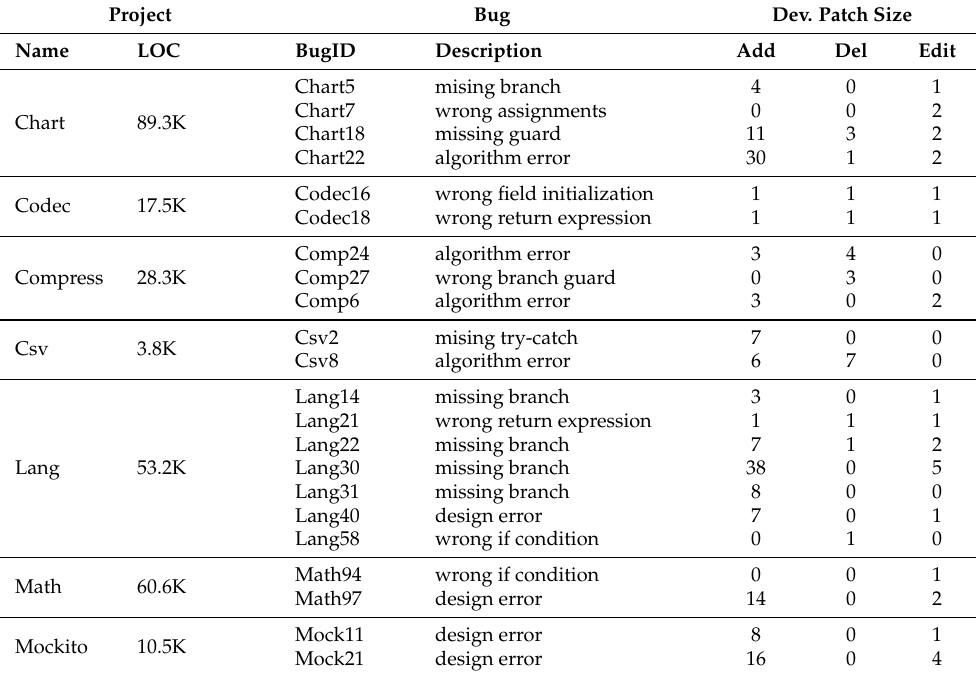
Table 3. Bugs used for studies.